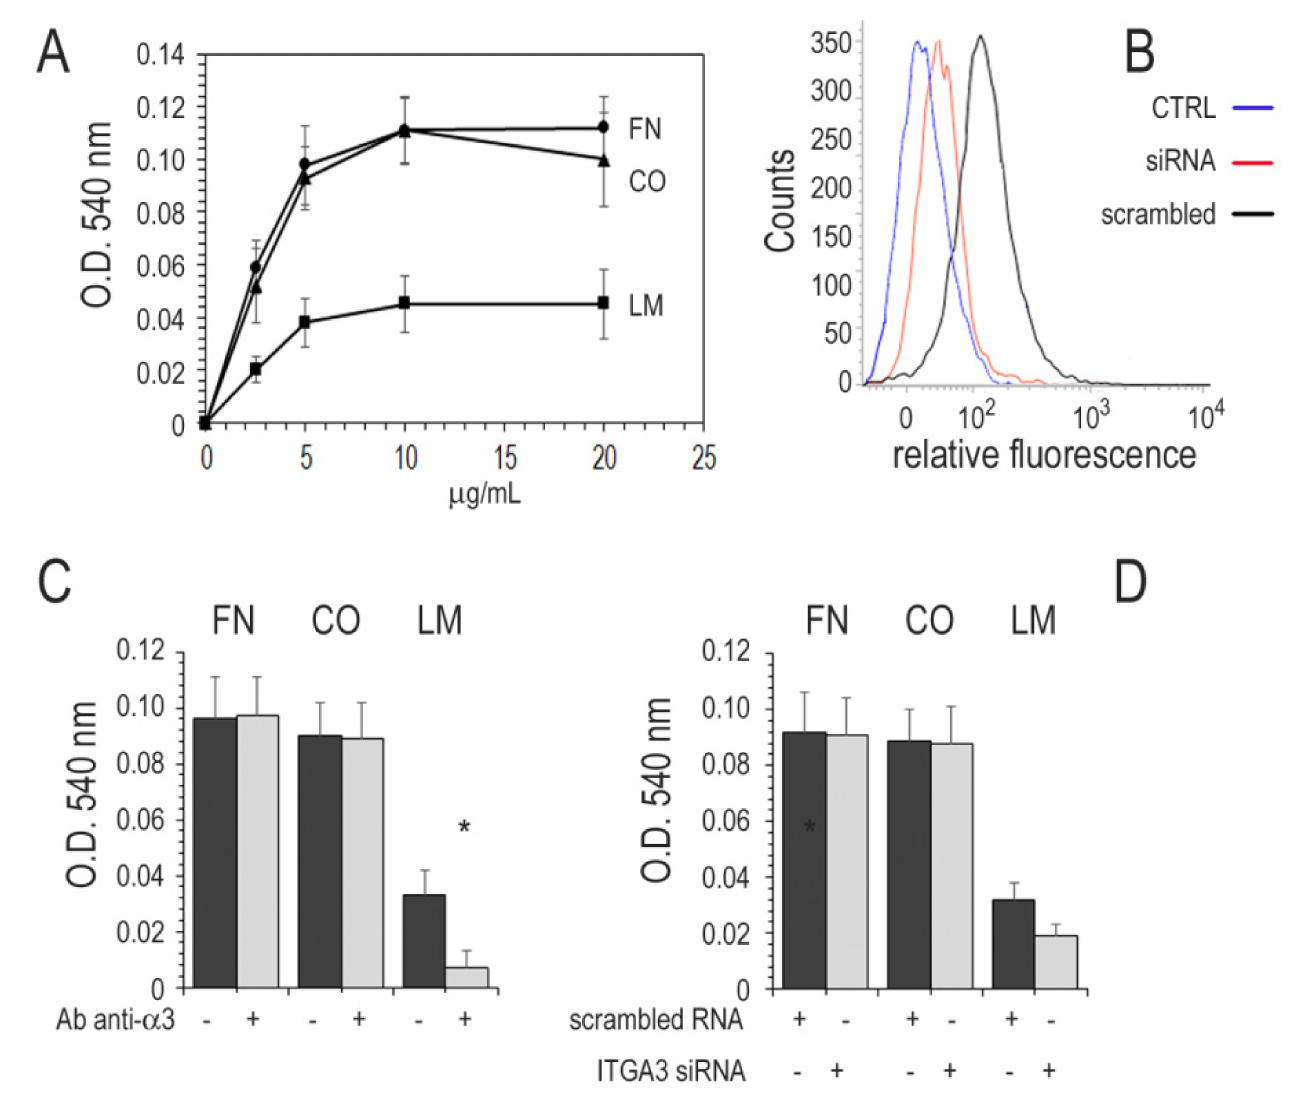
Figure 5. Cell attachment to ECM and role of α 3 β 1. ( A ) Microtiter wells were coated with different concentrations of FN, CO, or LM and saturated with heat-denatured BSA. Cells in calcium-and magnesium-containing PBS were added and incubated at 37 ◦ C for 1 h. The attached cells were measured as described in Materials and Methods. ( B ) The cells were transfected with ITGA3 siRNA duplexes (siRNA) or with scrambled RNA, and α 3 expression was assessed after 48 h by flow cytometry with anti- α 3 primary antibody (CTRL, no primary antibody). The mean inhibition of α 3 expression of 4 experiments was about 70%. ( C ) Microtiter wells were coated with 5 µ g/mL ECM and saturated with BSA. Cells were added to the plates with 1 µ g/mL of monoclonal antibody anti α 3 subunit (Ab anti- α 3). ( D ) Alternatively, an attachment assay was performed with cells transfected with ITGA3 siRNA or scrambled RNA. After 1 h at 37 ◦ C, the plates were gently washed, and attached cells were measured as described. All experiments were performed in quadruplicate. *, p < 0.001. Only experiments with BCPAP are shown, results in TPC-1 were all the